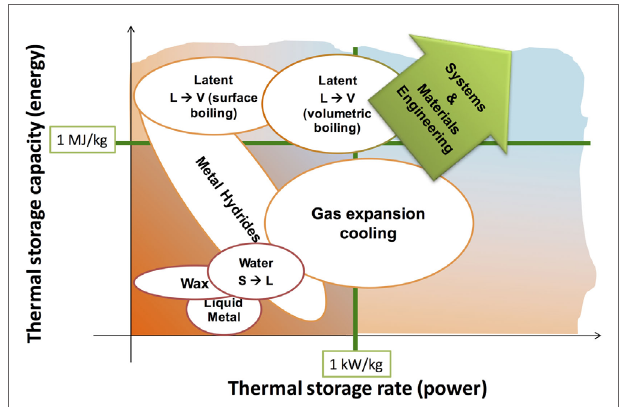
FiGUre 1 | notional map of energy and power densities of thermal storage approaches (l, liquid; S, solid; V, vapor) .